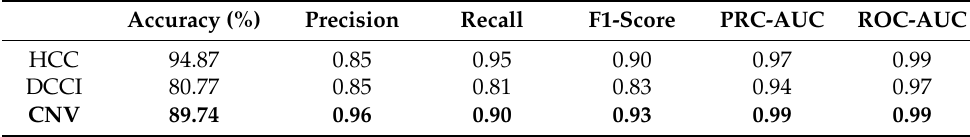
Table 1. CNV screening performance of the modified VGG19. Accuracy, precision, recall, F1- score, area under the curve (AUC) for precision-recall (PRC) and receiver operation character- istic (ROC) curves for the three classes of OCTA images (HCC: healthy choriocapillaris, DCCI: drusen/choriocapillaris impairment, CNV: choroidal